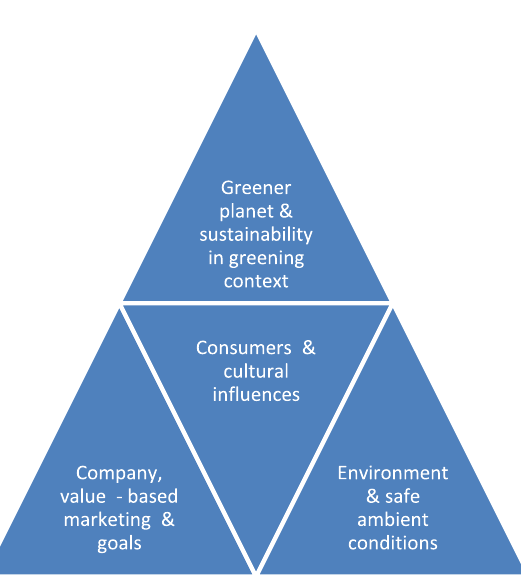
Fig. 4 Proposed model of sustainable marketing by chart